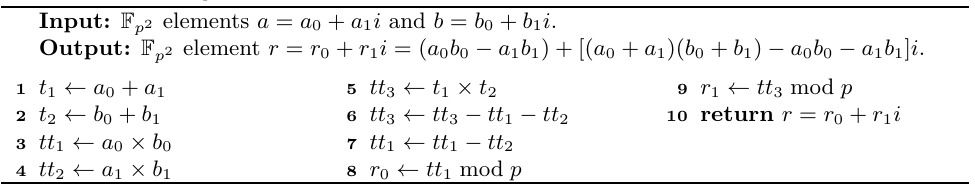
-multiplication with 1-way parallelization at F p -level. Algorithm 3: F p 2